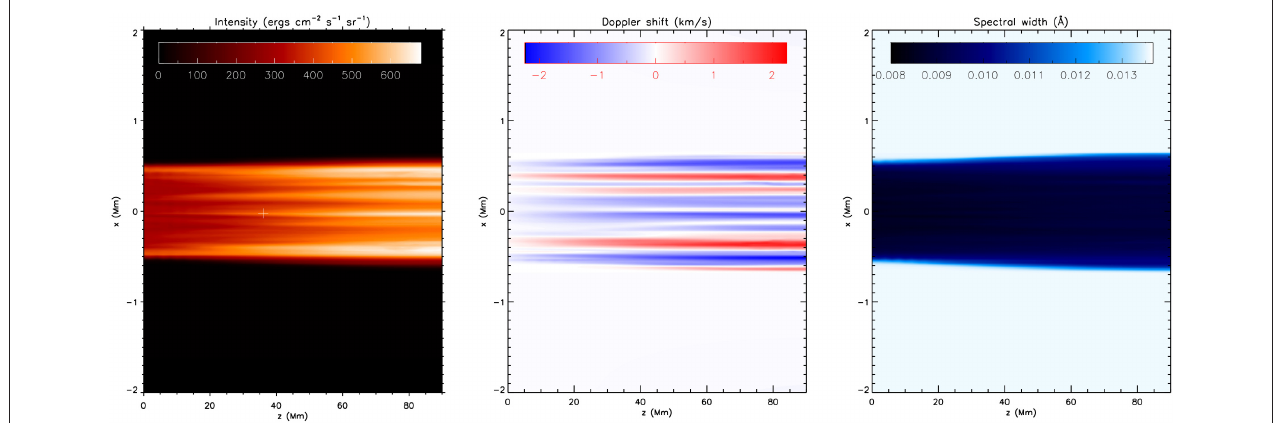
FIGURE 2 | The typical data products from FoMo. The left panel shows the intensity, the middle panel the Doppler shift, and the right panel the line width. This rendering has been performed for the data used for the code validation in Section 2.6. The white “